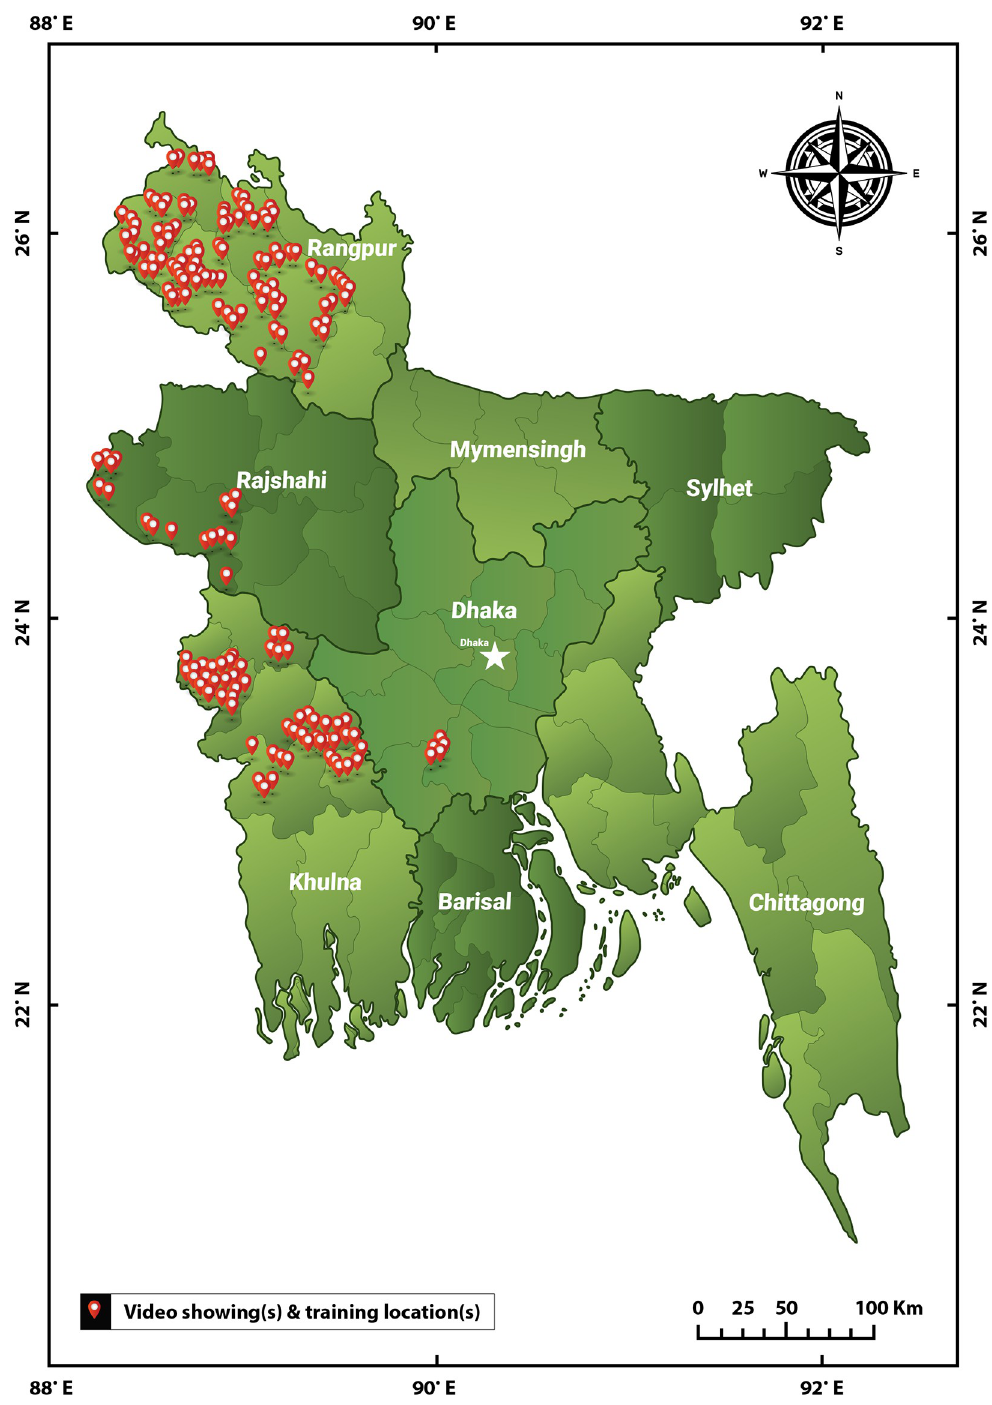
Fig 1. (A) Agricultural extension services training sites in four of the eight national divisions of Bangladesh: Rangpur, Dhaka, Khulna, and Rajshahi and (B) the eight Administrative Divisions of Bangladesh (this file is made